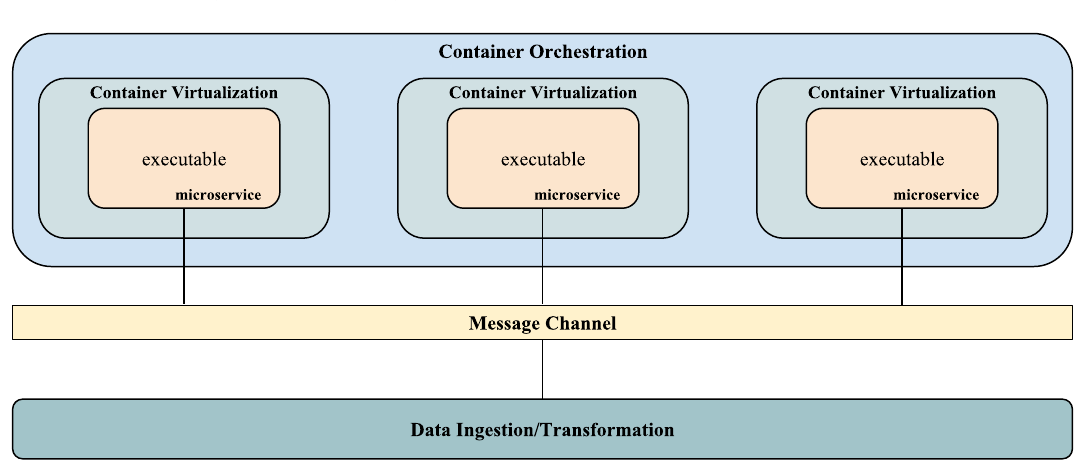
Figure 2. Concepts and state-of-the-art technologies used for the presented